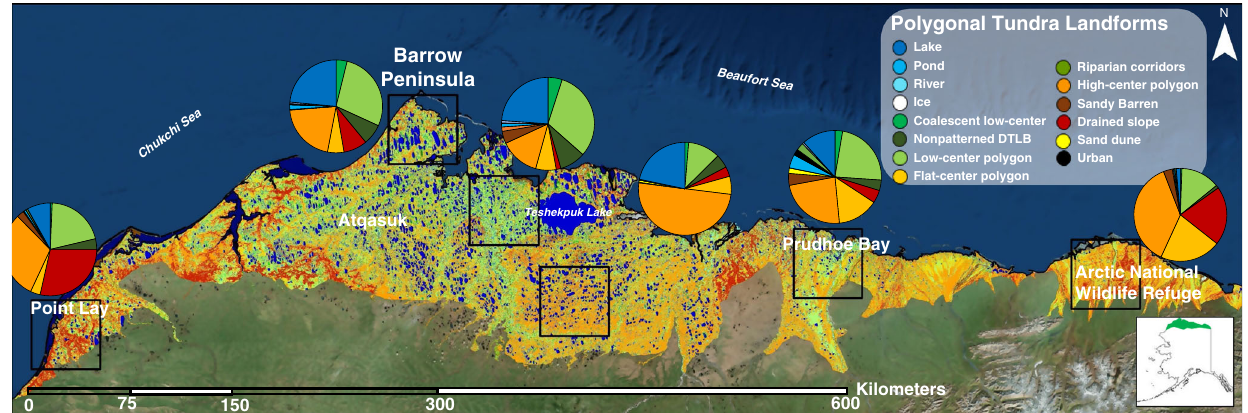
Fig. 1 Heterogeneous distribution of polygonal tundra landforms on the Arctic Coastal Plain of Alaska. The polygonal tundra map 10,13 is projected over ArcGIS World Imagery basemap (Sources: Esri, DigitalGlobe, GeoEye, i-cubed, USDA FSA, USGS, AEX, Getmapping, Aerogrid, IGN, IGP, swisstopo, and the GIS User Community).